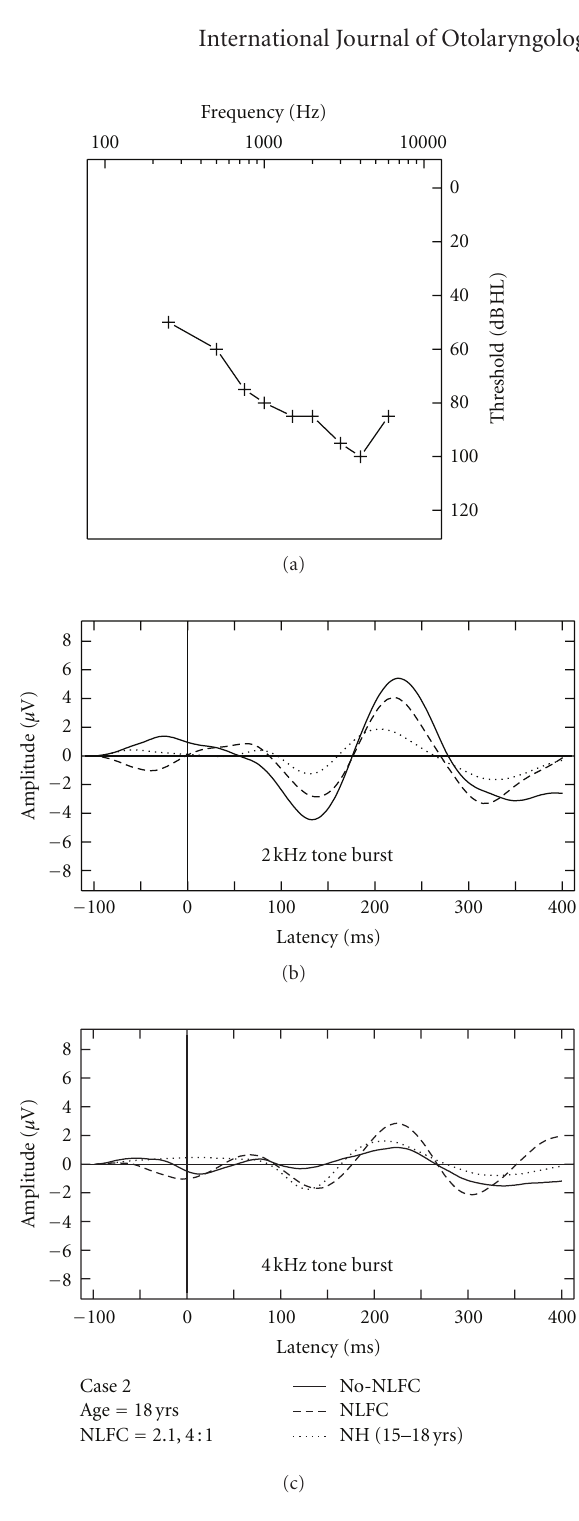
Figure 3: Case-specific grand mean CAEPs displayed across stimulus types and hearing aid conditions: no-NLFC (solid line), NLFC active (dashed line), and for each participant’s age-matched NH group (dotted line). Participant age and prescribed NLFC settings (cut-o ff frequency, compression ratio) are indicated in the legend. The top left corner pane displays test ear hearing thresholds, suspected cochlear dead regions (DR), and responses beyond the audiometric test range.